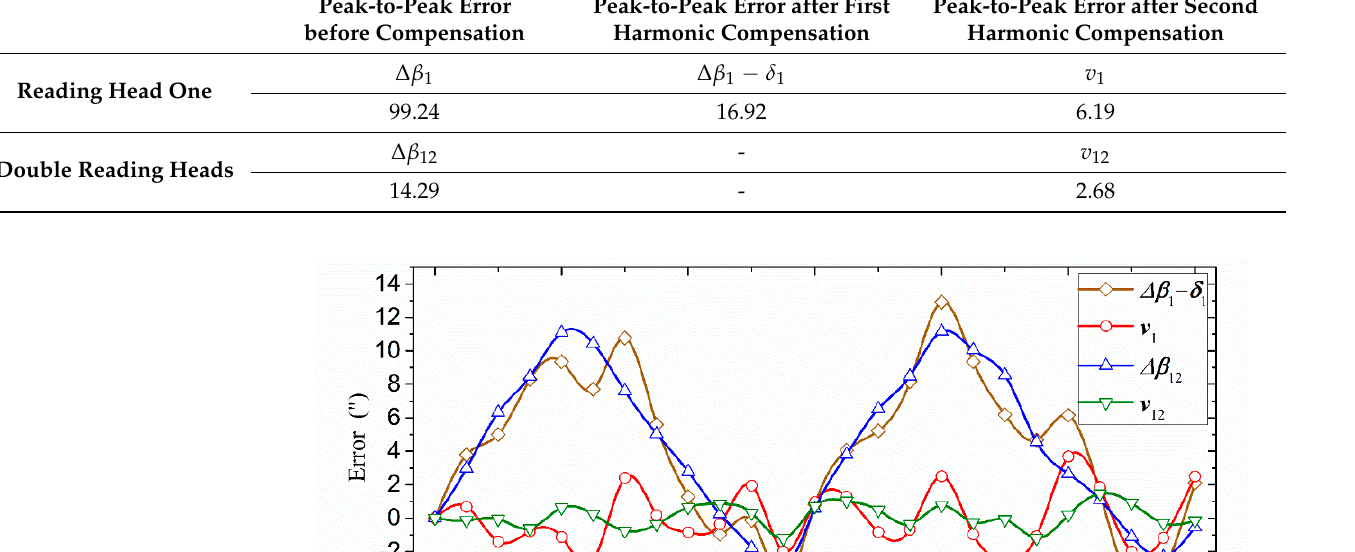
Table 7. Comparison of the peak-to-peak error between reading head one and the double reading heads (unit: arc second). Peak-to-Peak Error